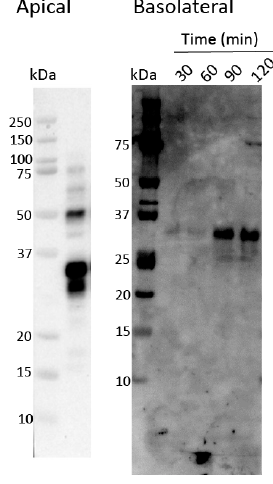
Figure 3. Epithelial transport of osteopontin (OPN). Caco-2 cells were grown on transwell membranes and incubated with OPN in the apical compartment representing the intestinal luminal side. Samples from apical and basolateral compartments were collected separately after the indicated times, and OPN was detected in the medium by Western blotting using polyclonal anti-OPN antibodies. The Western blot of the apical sample is from medium collected after 2 h incubation with OPN, and it is representative of all incubation times. The blots are representative of three individual